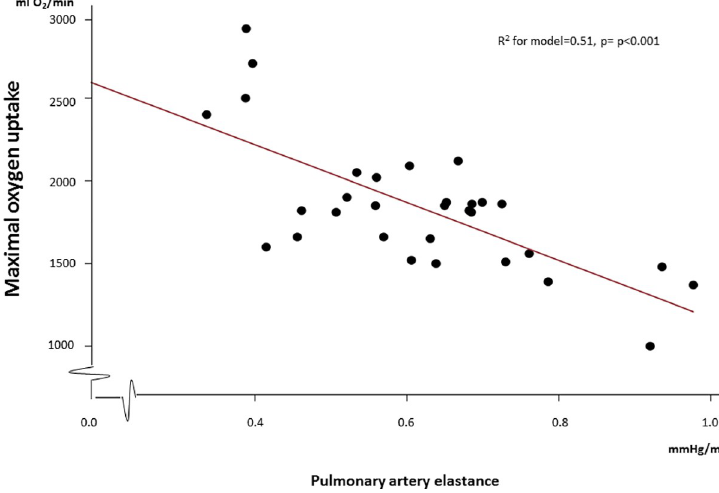
Fig 3. Association between maximal oxygen consumption and pulmonary artery elastance at maximal exercise.